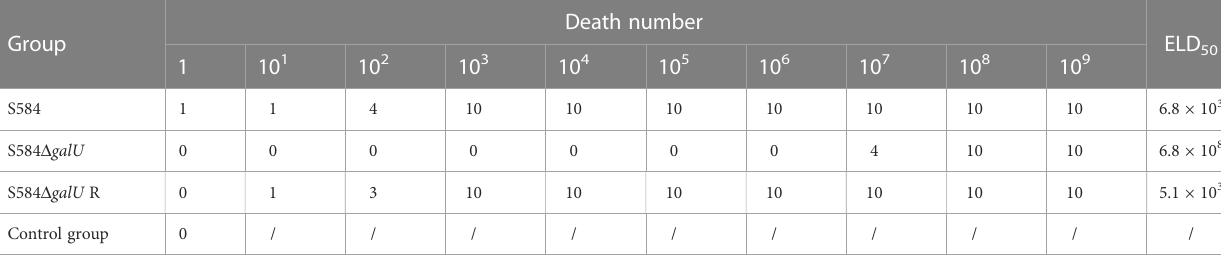
TABLE 1 Virulence analysis of three strains in chicken embryos.